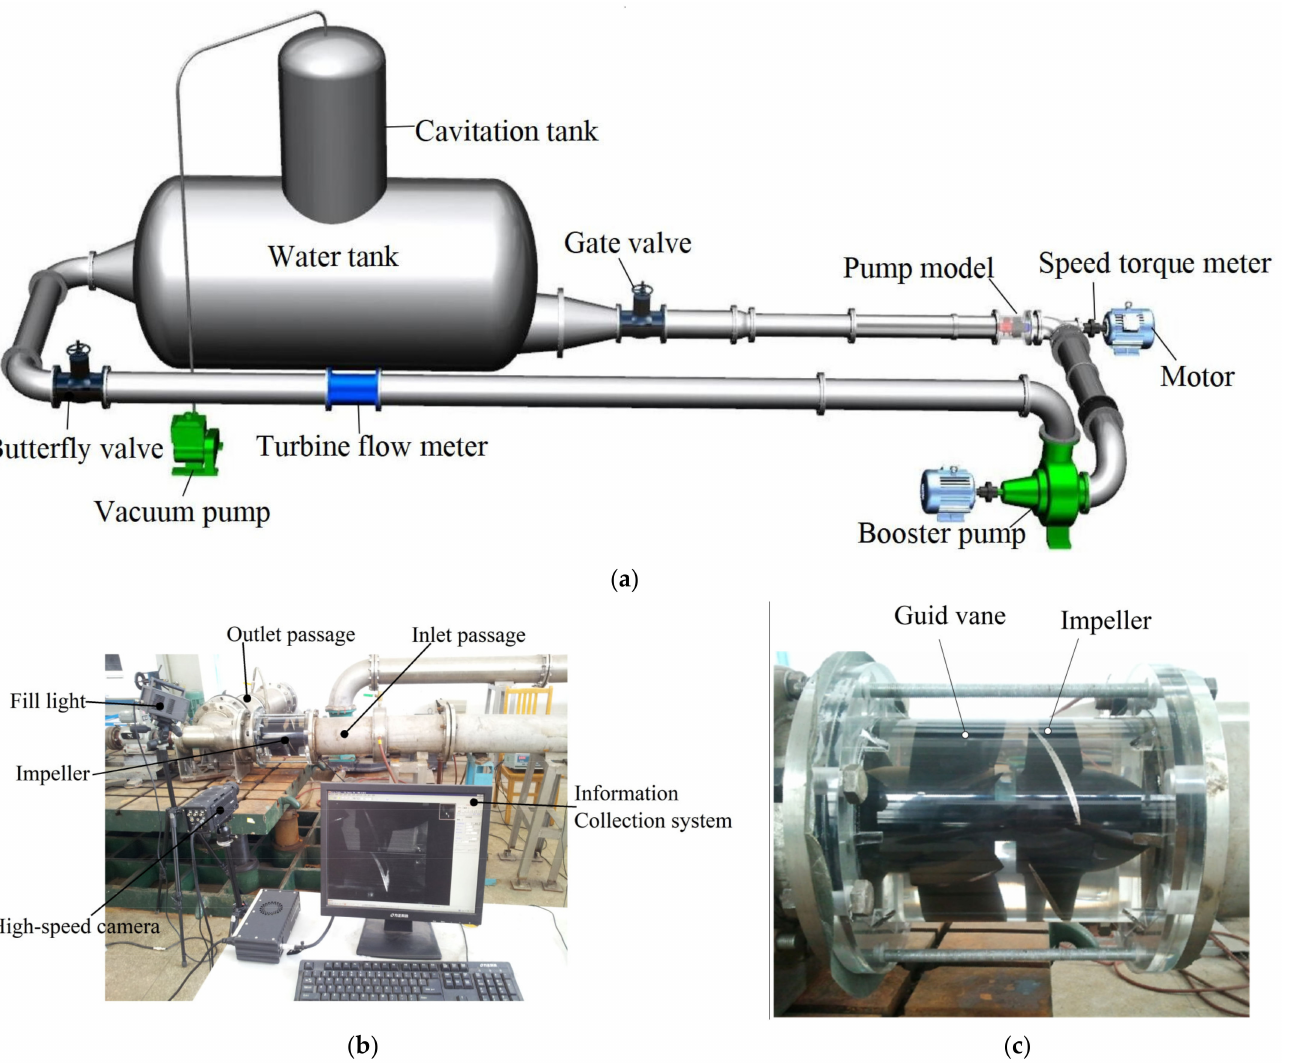
Figure 3. Experimental equipment of the axial-flow pump to examine the external characteristics and cavitation. ( a ) The axial-flow pump loop; ( b ) High-speed imaging system; ( c ) Test